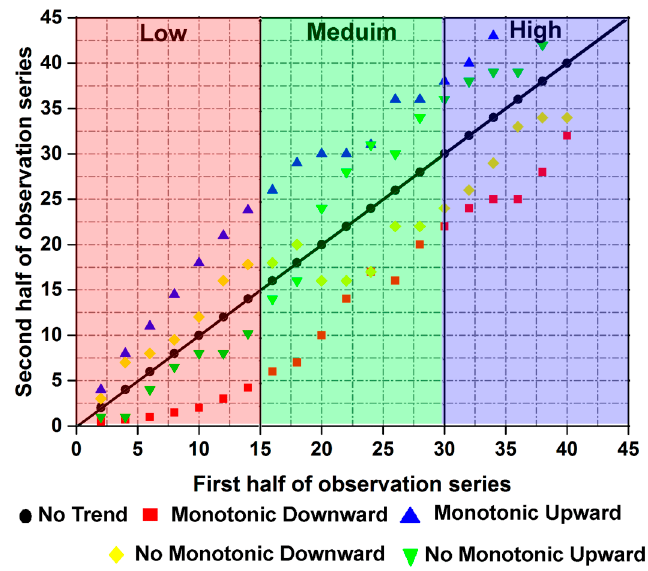
Figure 2. Innovative trend methodology template (the black dots are data with no trends) [41].